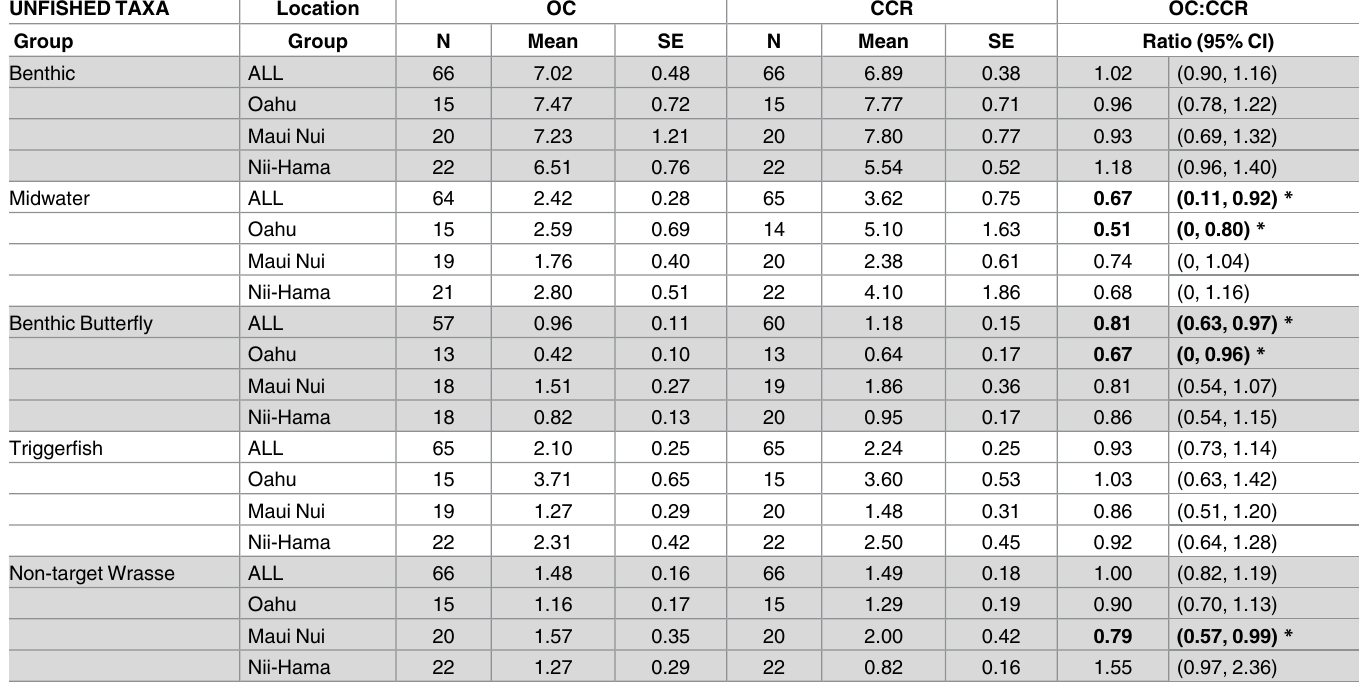
Table 3. Summarytable for biomass (g/m 2 ) of unfished taxa. N = numberof sites with the group observed, OC:CCR Ratio = ratio of mean OC value to mean CCR value with 95% confidenceinterval (low 95% CI, high 95% CI). Significant differencesbetweenCCR and OC (i.e. 95% CI of OC:CCR not overlap- ping 1) are marked with an asterisk ( * ) and shown in bold. Number of sites at each location was Oahu: n = 15, Maui Nui: n = 20, Niihau-Hamakua: n = 22 and all sites: n = 66. Location groupsare listed in order of presumeddecliningspearfishing pressure from Oahu (highest) to Niihau-Hamakua (lowest). UNFISHED TAXA Group